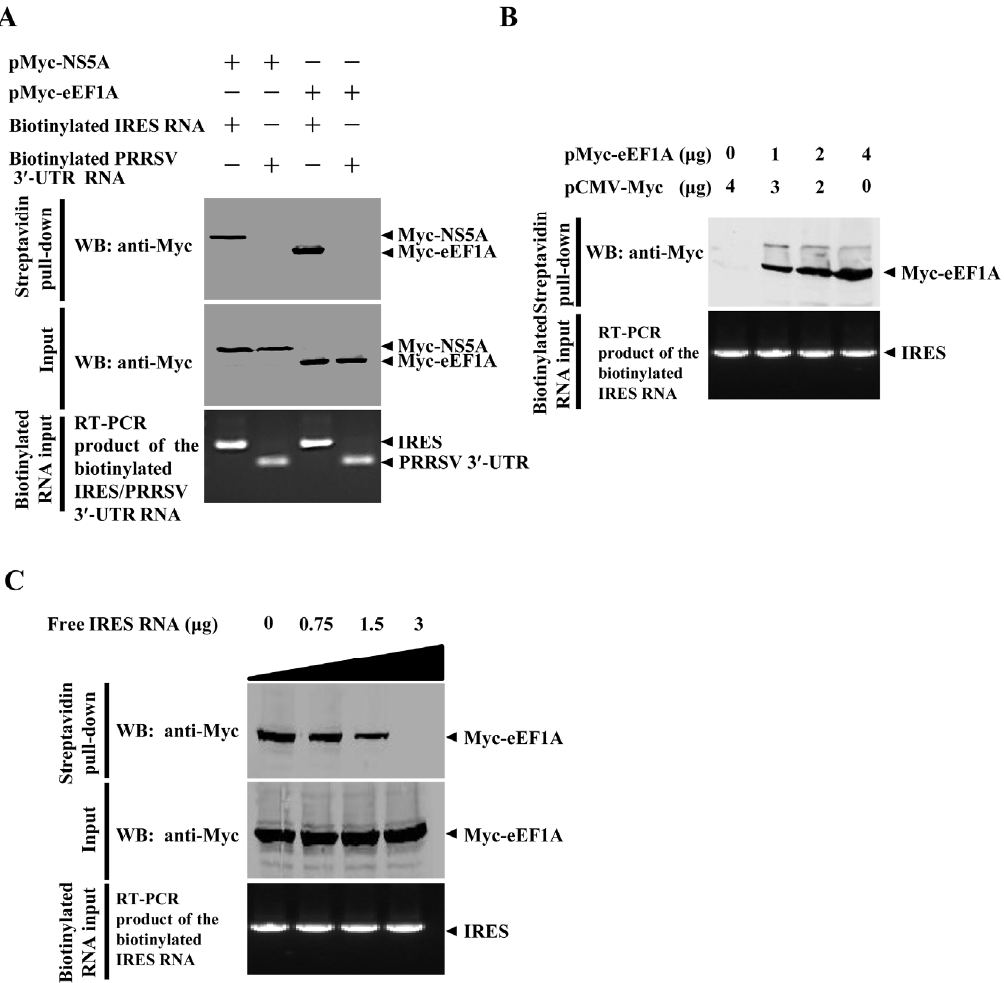
Figure 6. eEF1A binds to the CSFV internal ribosome entry site (IRES). ( A ) eEF1A as well as NS5A interacts with the CSFV IRES. HEK293T cells were transfected with pMyc-eEF1A or pMyc-NS5A. The cell lysate was incubated with the biotinylated CSFV IRES or porcine reproductive and respiratory syndrome virus (PRRSV) 3 1 -UTR, followed by incubation with streptavidin beads. The bound proteins were analyzed by immunoblotting using the anti-Myc monoclonal antibody (MAb) (1:1000); ( B ) eEF1A interacts with the CSFV IRES in a dose-dependent manner. HEK293T cells grown in the 6-well plate were transfected with an increased amount of pMyc-eEF1A (0, 1, 2 and 4 µ g), followed by streptavidin pulldown assay as described above; ( C ) Competitive RNA pulldown assay. HEK293T cells grown in the 6-well plate were transfected with the indicated pMyc-eEF1A (4 µ g). The cell